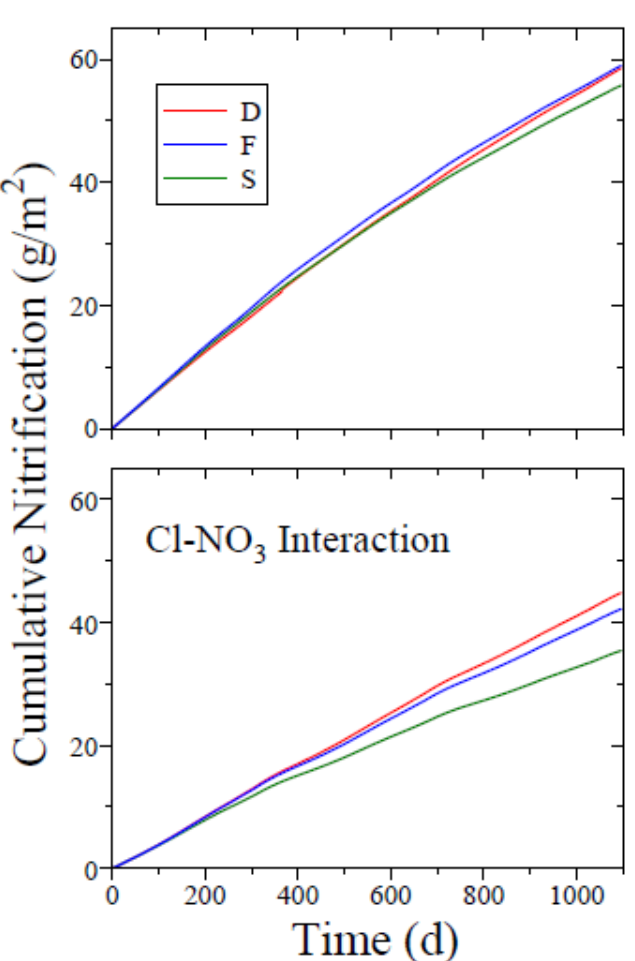
Figure 8. Cumulative mass of nitrate gained by nitrification, as a function of time, for the different scenarios examined. Top panel — the effect of the chloride on nitrification was disregarded.